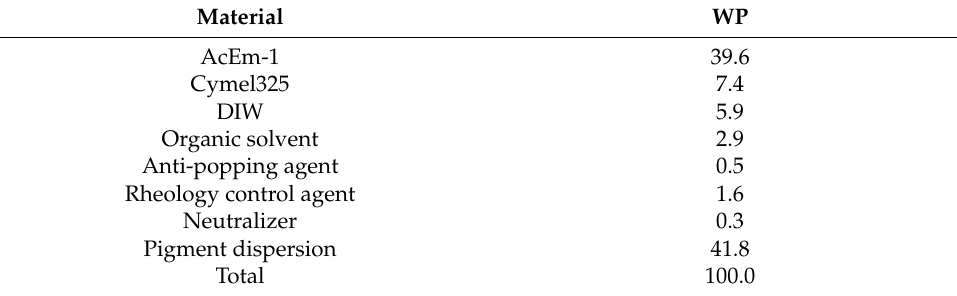
Table 2. Formulation of waterborne primer surfacer